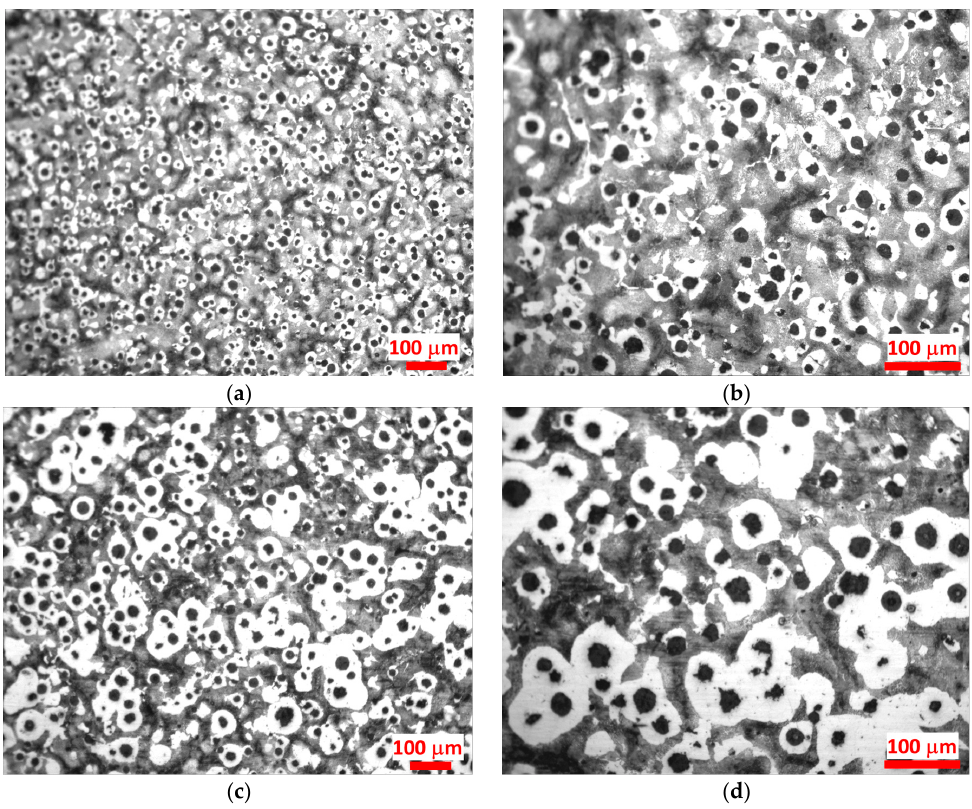
Figure 2. Optical images of the as-cast microstructures of ( a ) Alloy O (100×), ( b ) Alloy O (200×), ( c ) Alloy M (100×) and ( d ) Alloy M (200×) (2% nital etched).